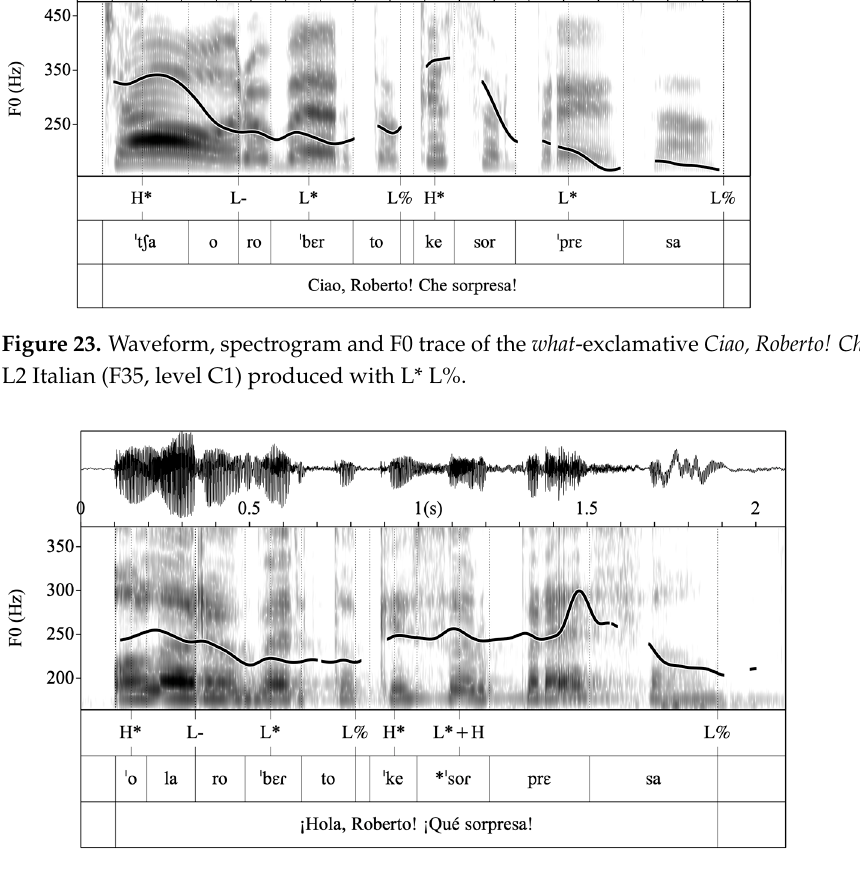
Figure 24. Waveform, spectrogram and F0 trace of the what -exclamative ¡Hola, Roberto! ¡Qué sorpresa!